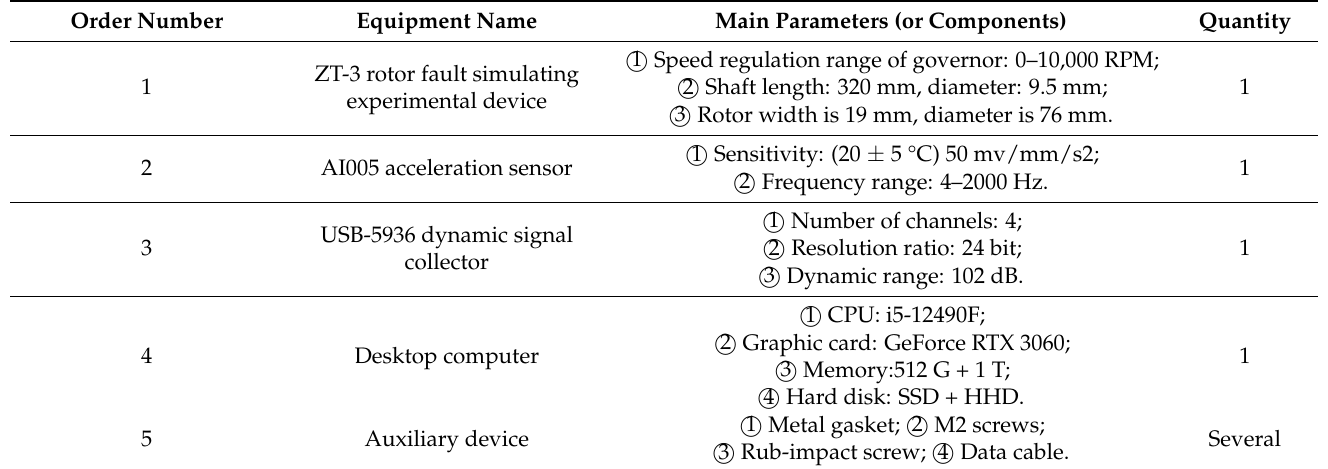
Table 2. Equipment list of the